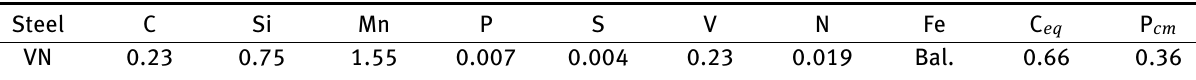
Table 1: Chemical composition of the experimental steel (wt. %). Steel